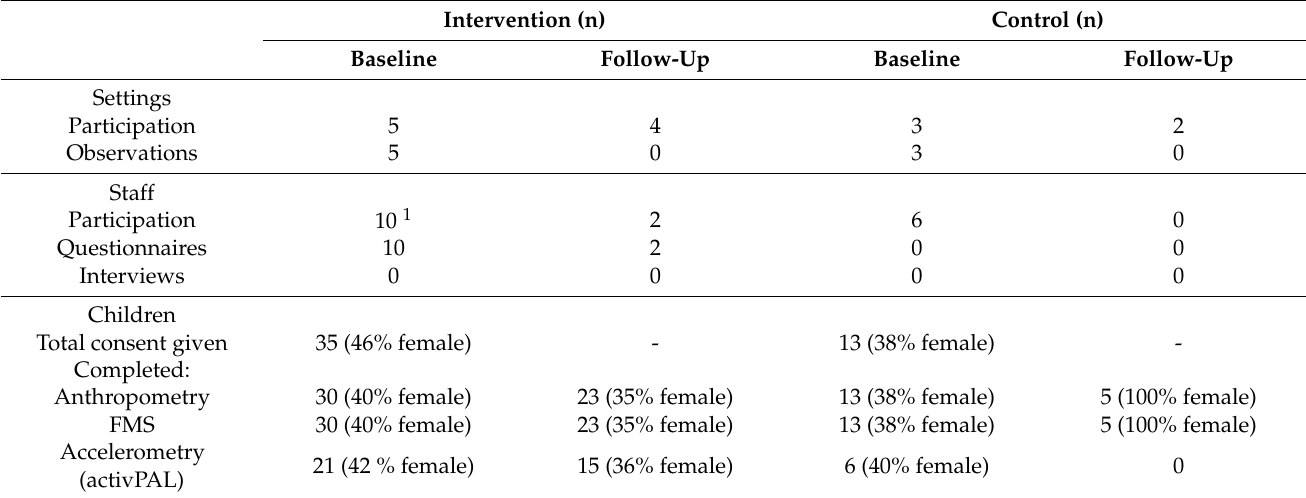
Table 2. Numbers of settings/Educators/children involved in the